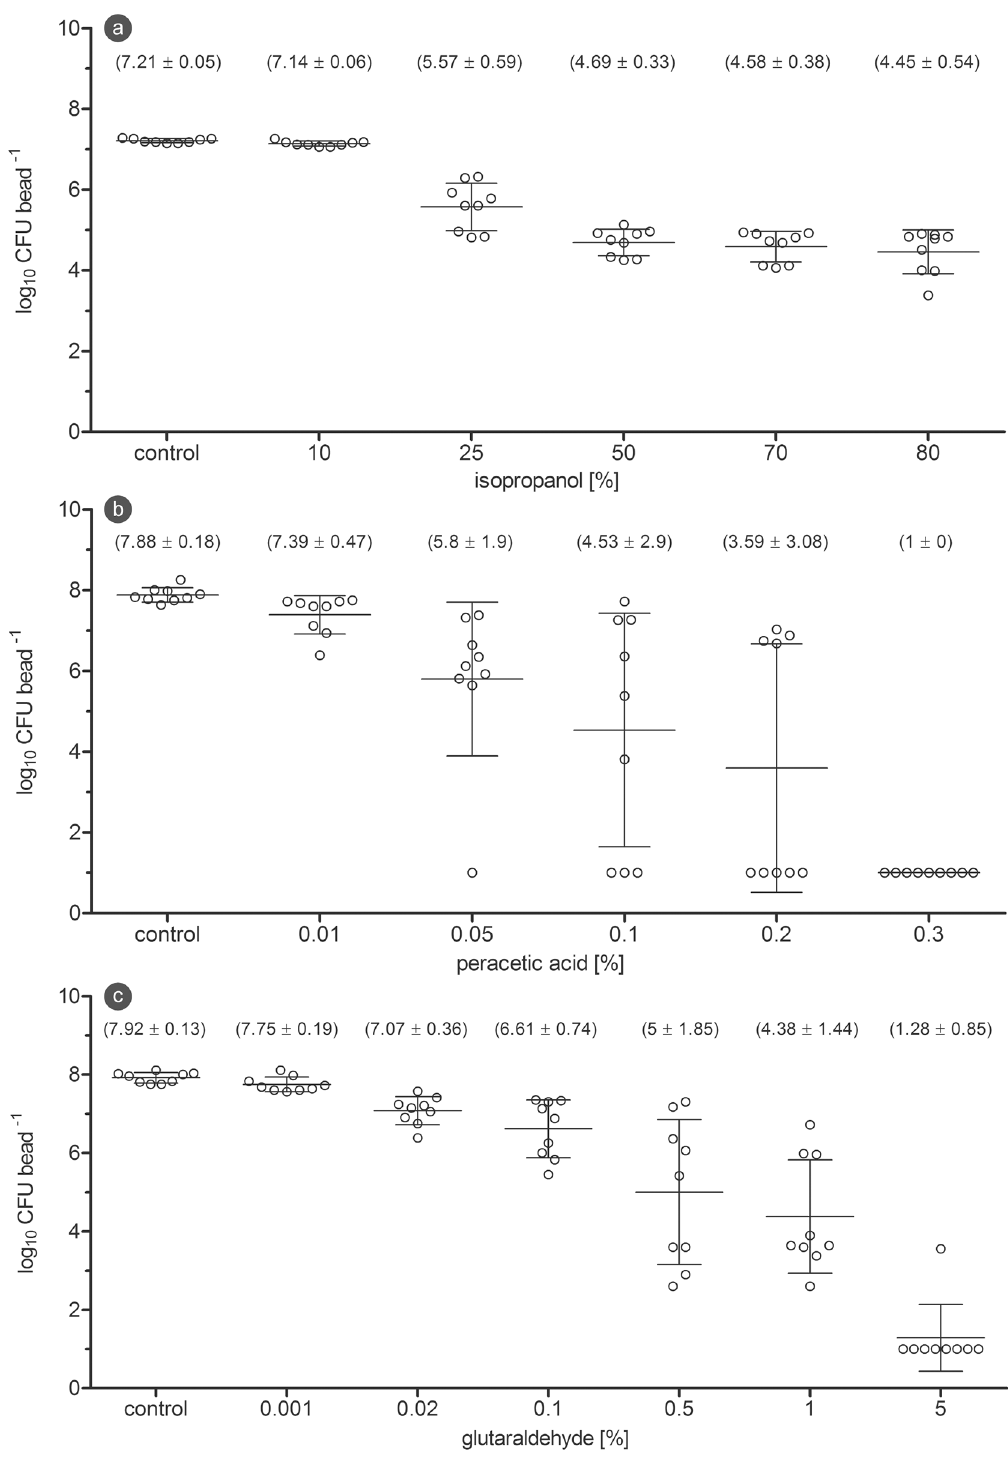
Fig 4. Disinfectant efficacy testing on biofilm. (a) CFU counts after 30 min isopropanol treatment of P . aeruginosa biofilm. (b) CFU counts after 10 min peracetic acid treatment of P . aeruginosa biofilm. (c) CFU counts after 30 min glutaraldehyde treatment of P . aeruginosa biofilm. (The horizontal lines through the data points represent mean and standard deviation).